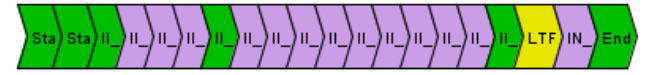
Figure 5. A trace with multiple skipped events and thus relatively low fitness (89.6%).